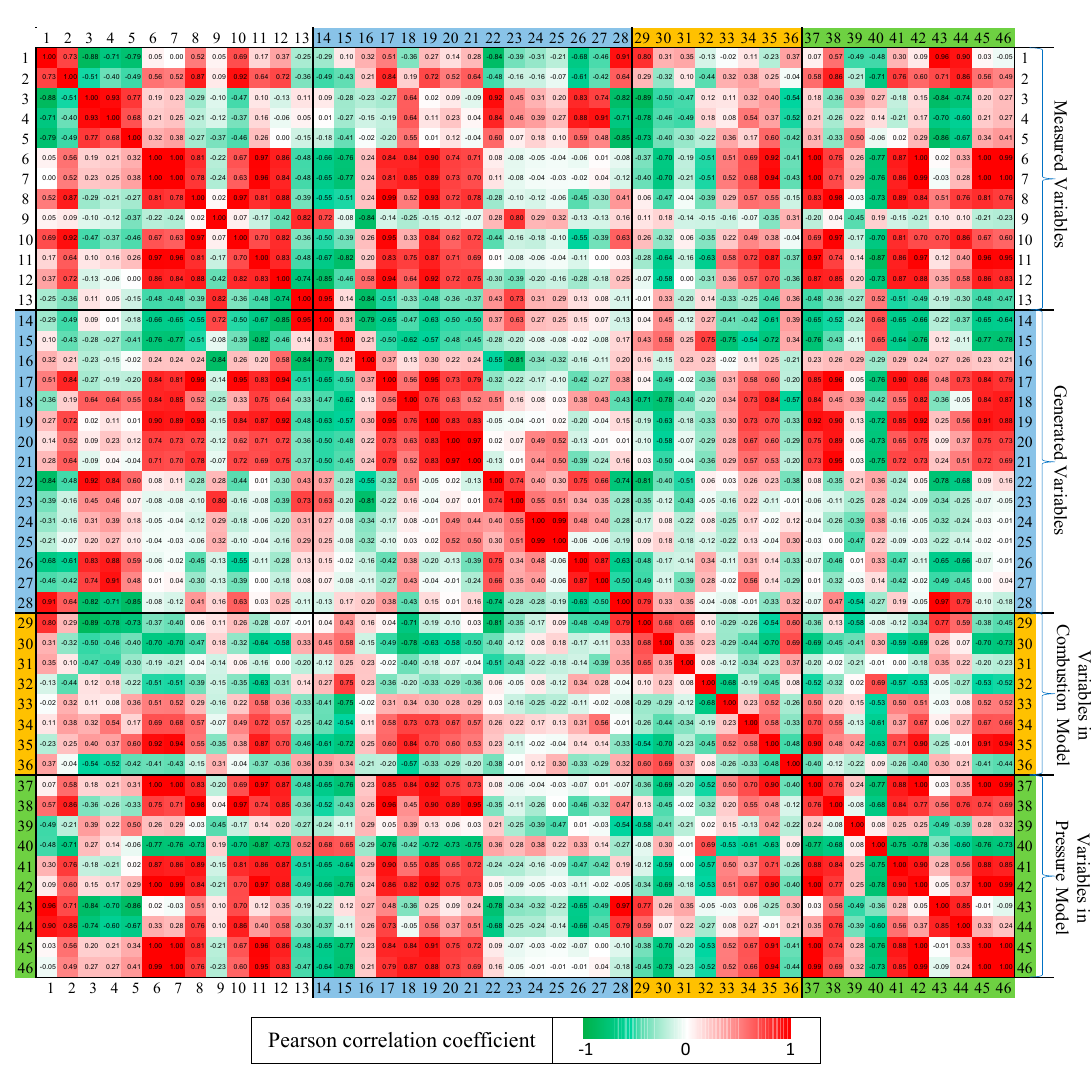
Figure A2. Pearson correlation coefficients for all the possible combinations of the variables reported in Table A1.